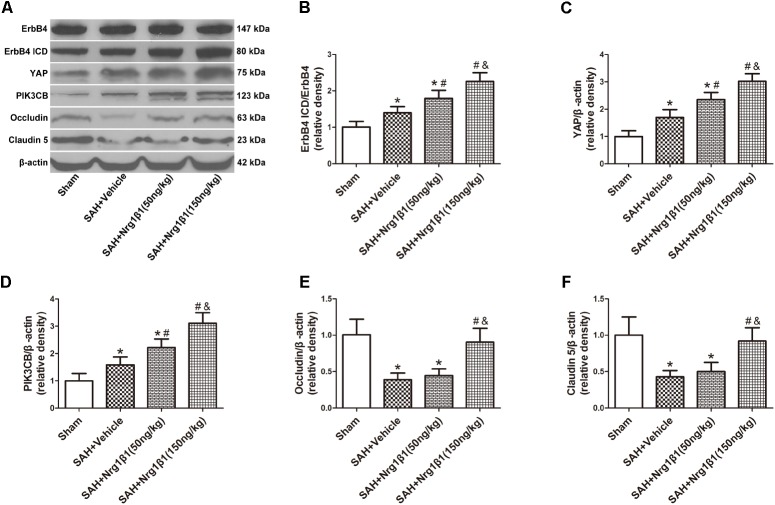
ErbB4 activation by Nrg1β1 administration stabilizes tight junction proteins. Representative western blot bands of ErbB4, YAP, PIK3CB, Occludin and Claudin 5 (A), the expression of ErbB4 ICD/ErbB4 (B), YAP (C), and PIK3CB (D) were increased at 24 h after SAH induction and were further up-regulated by high-dose Nrg1β1 (150 ng/kg) administration. SAH induction significantly reduced the expression of Occludin (E) and Claudin-5 (F). Nrg1β1 (150 ng/kg) administration significantly reversed this effect. n = 6, ∗p < 0.05 versus sham; #p < 0.05 versus SAH + vehicle; &p < 0.05 versus SAH + Nrg1β1 (50 ng/kg).